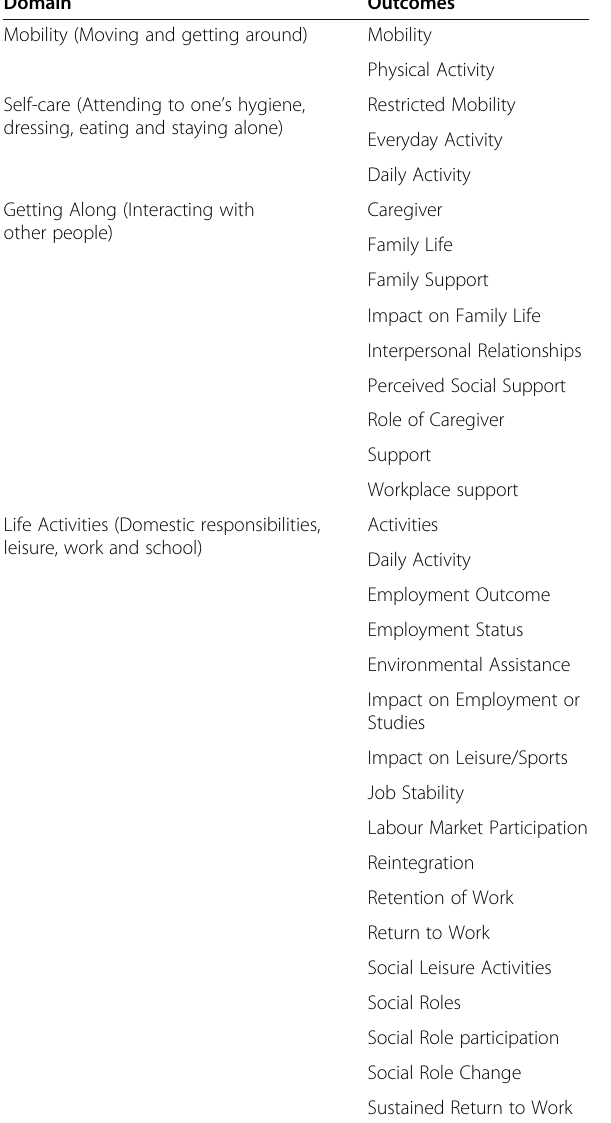
Table 3 Classification of Reported Outcomes into Domains based on WHODAS 2.0